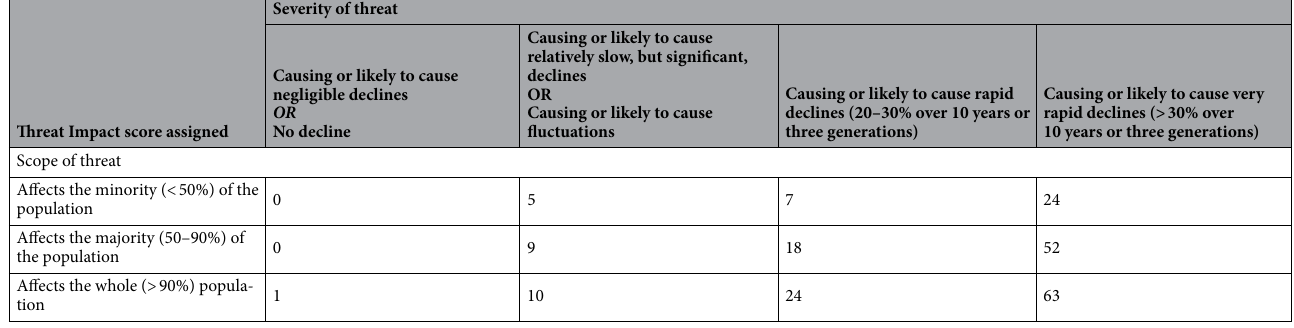
Table 1. Numeric representation of threat